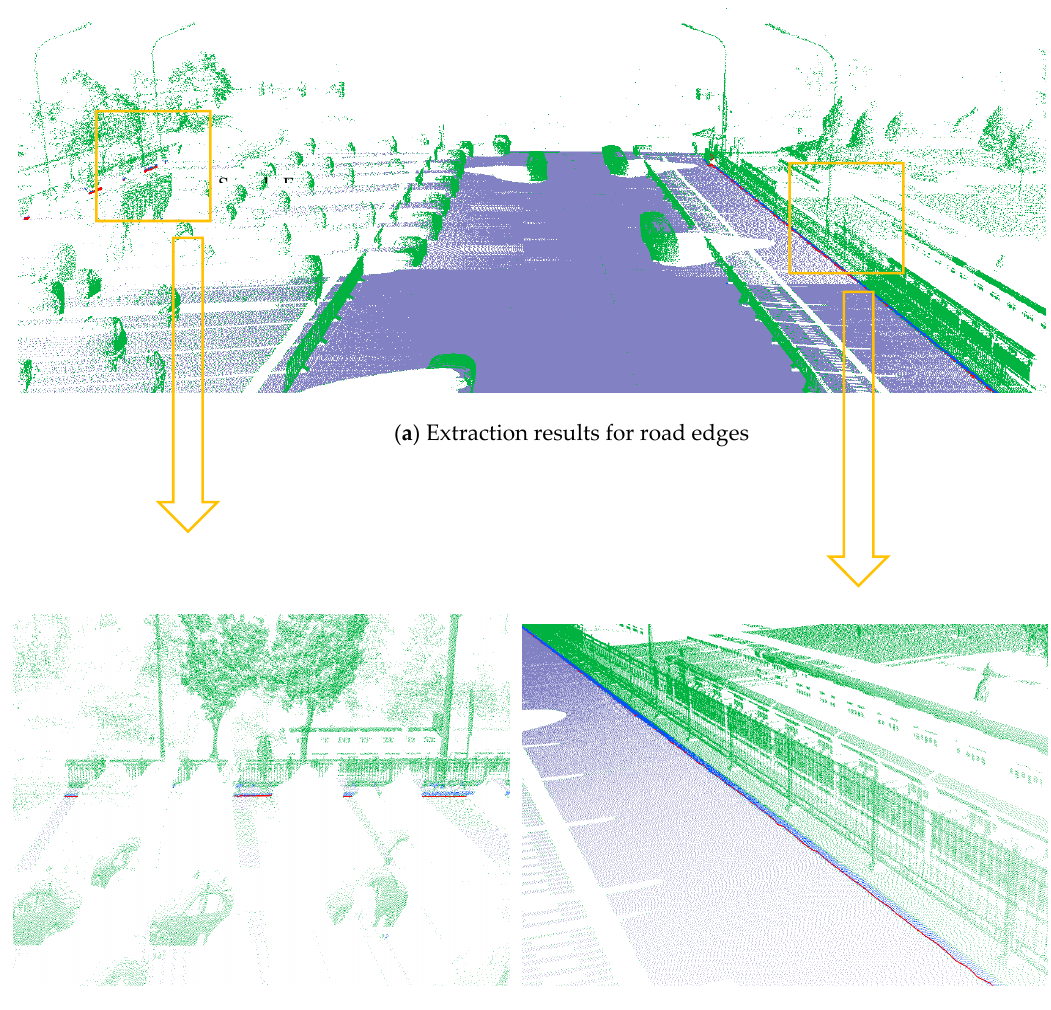
Figure 13. Extraction results.